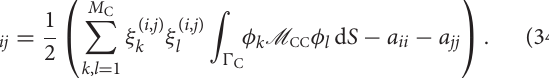
Frontiers in Built Environment |